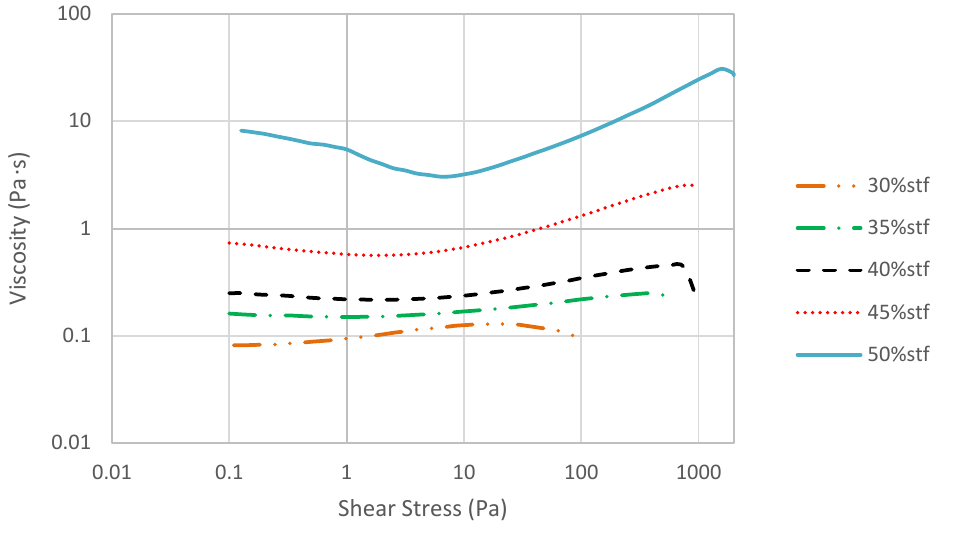
Figure 6. Effect of shear stress on viscosity at 50 °C.